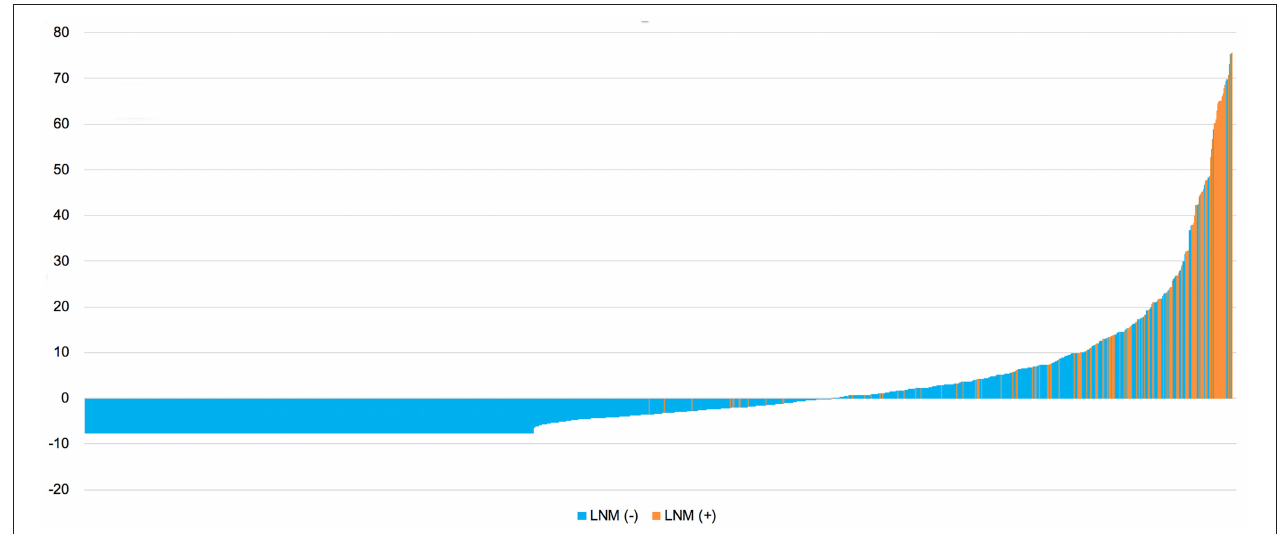
FIGURE 7 | Standardized predictive risk probabilities of LNM calculated by the nomogram for all patients. LNM, lymph node metastasis.